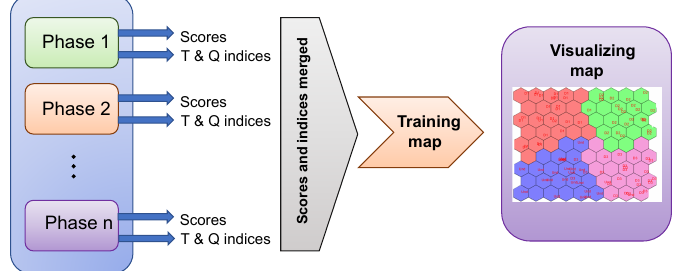
Figure 10. Classification methodology using self-organizing maps.